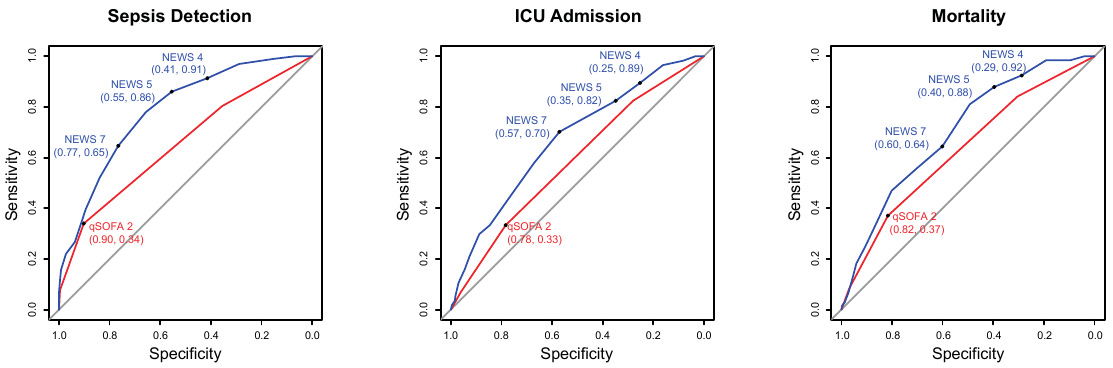
Figure 3. Receiver operating characteristic (ROC) curves for sepsis detection, ICU admission, and 28-day mortality for NEWS and qSOFA scores. ROC curves of NEWS (blue) and qSOFA (red). The area under the ROC curves (AUC) for NEWS and qSOFA were 0.789 (95% CI 0.75–0.82) vs. 0.65 (95% CI 0.61–0.69) for sepsis detection; 0.67 (95% CI 0.60–0.744) vs. 0.58 (95% CI 0.51–0.68) for ICU admis- sion and 0.70 (95% CI 0.65–0.75) vs. 0.63 (95% CI 0.58–0.68) for 28-day mortality.